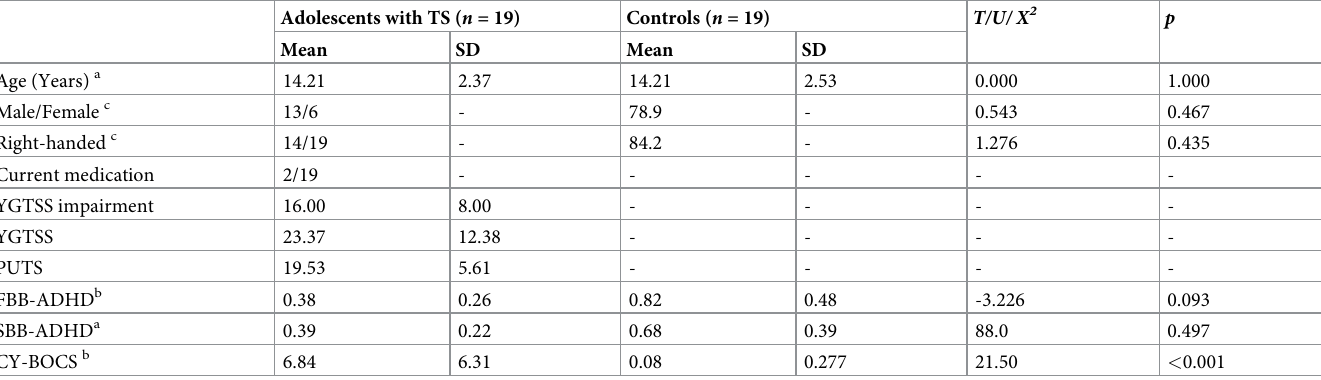
Table 1. Demographic, clinical and neuropsychological characteristics of adolescents with TS and healthy controls. Adolescents with TS ( n = 19) Controls ( n =